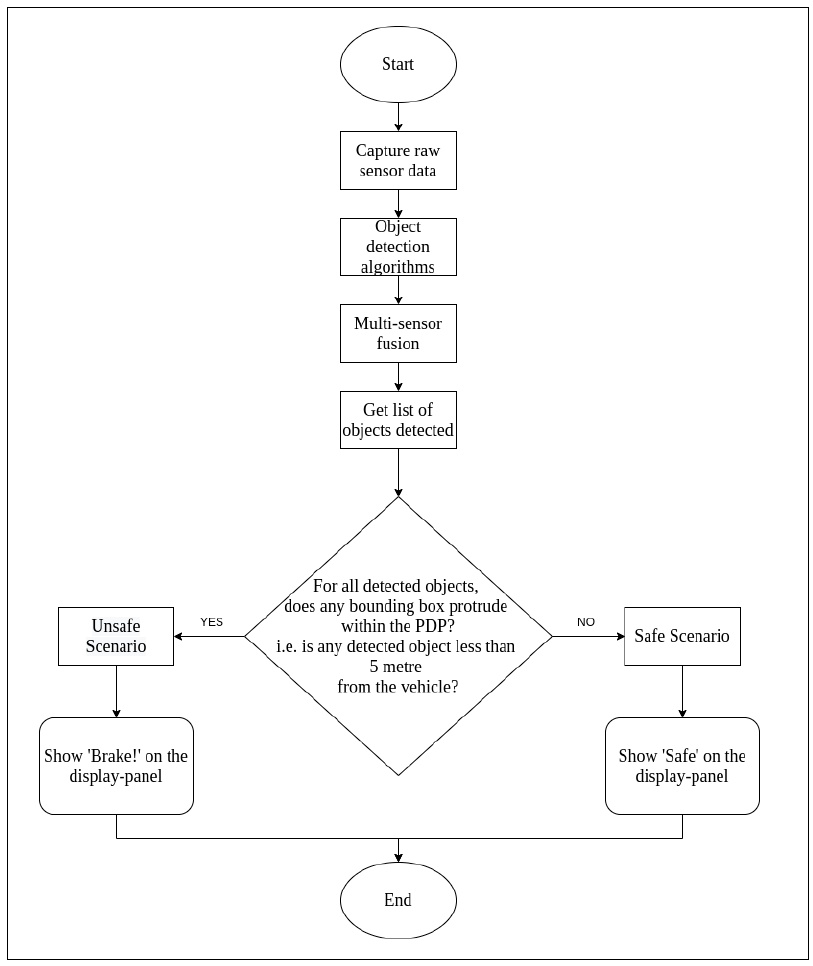
Figure 15. Flow chart for EBA functionality.